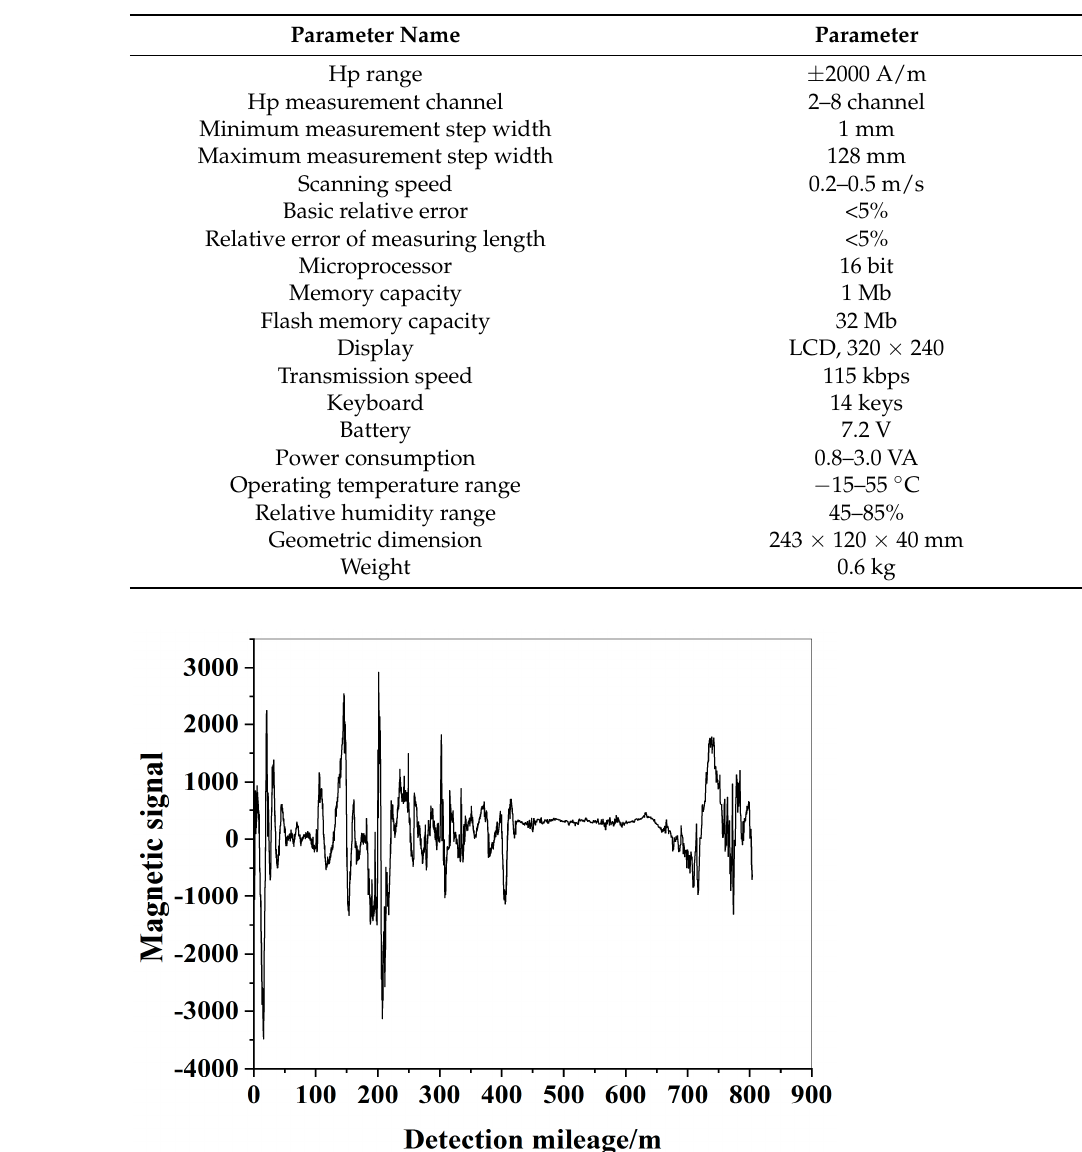
Figure 4. SNR values under different wavelet basis functions.